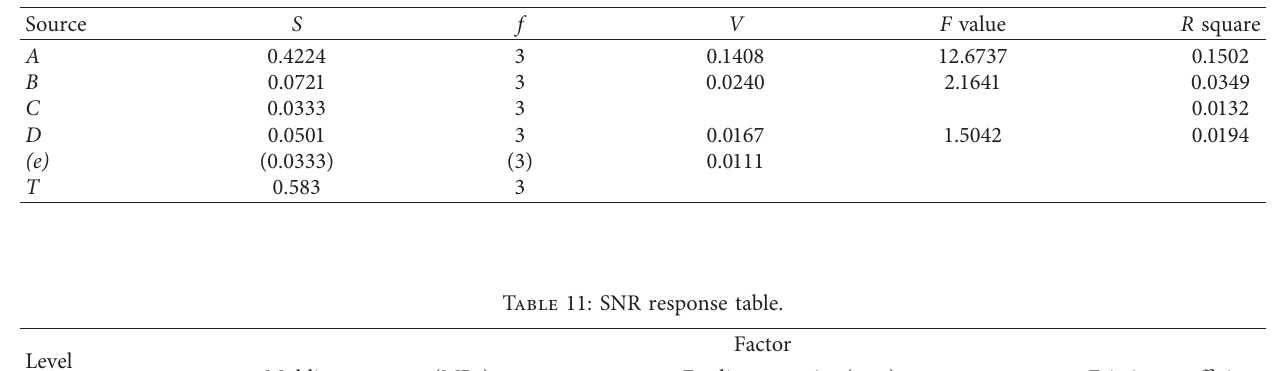
Table 10: Variance analysis